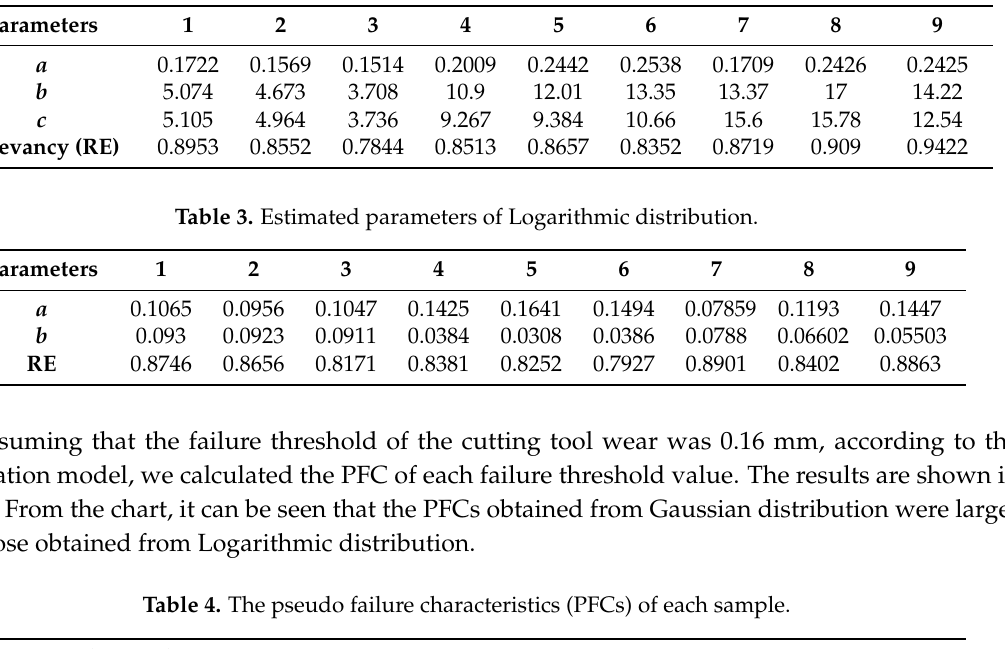
Table 2. Estimated parameters of Gaussian distribution.